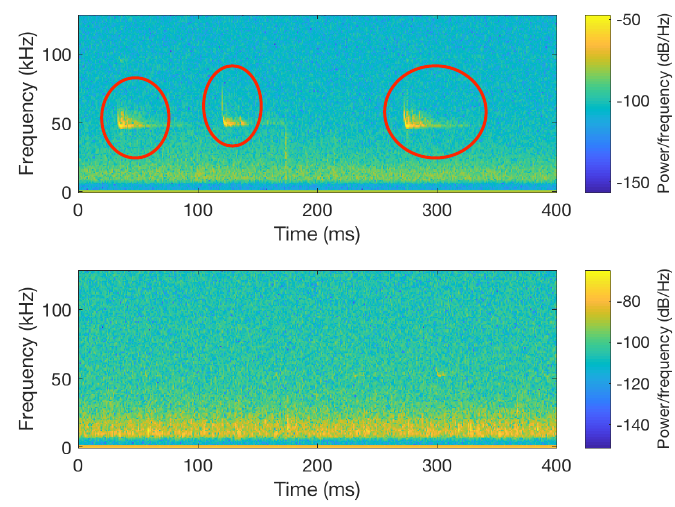
Figure 5. Comparison of bat’s call (upper spectrogram) and silence (lower spectrogram). In the upper plot there is a clear differentiation between the bat call pulses and the silence periods between them.